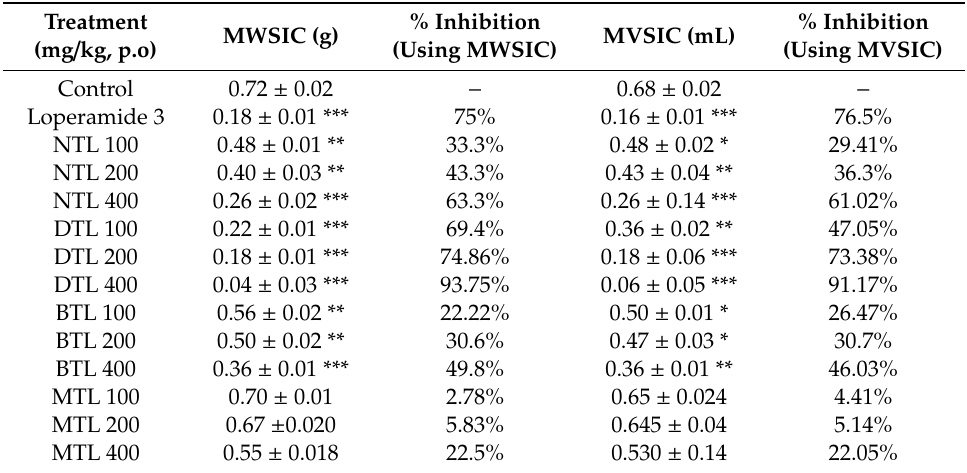
Table 3. E ff ect of methanol extract of T. leucostaphylum leaves and its derived fractions on castor oil induced intraluminal fluid accumulation in mice. Treatment (mg / kg, p.o)